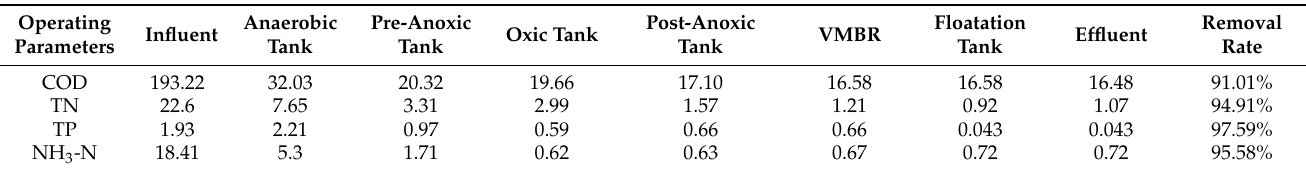
Figure 7. Removal of ( a ) COD, ( b ) TN, ( c ) TP, and ( d ) NH 3 -N of stage II. Table 2. The average of COD, TN, TP, and NH3-N, and removal rate of every